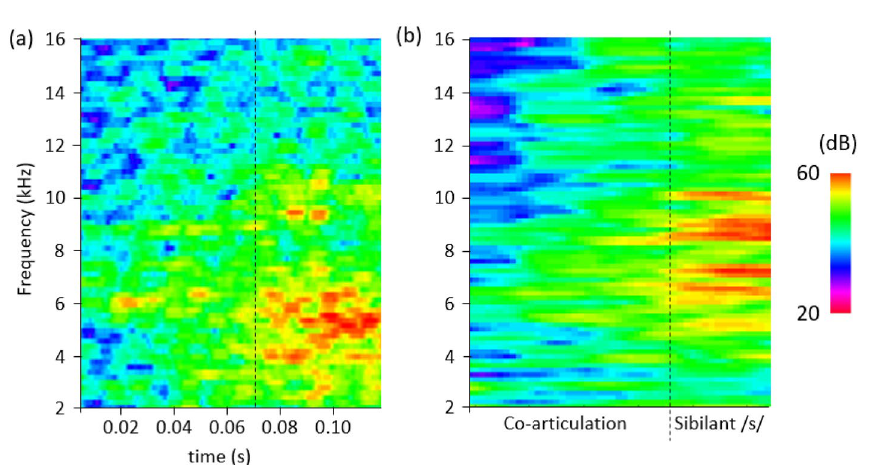
Figure 4. ( a )–( c ) Instantaneous flow field and ( d )–( f ) pressure fluctuation along the sagittal plane at ( a , d ) t = 0.01 s, ( b , e ) t = 0.05 s and ( c , f ) t = 0.10 s.